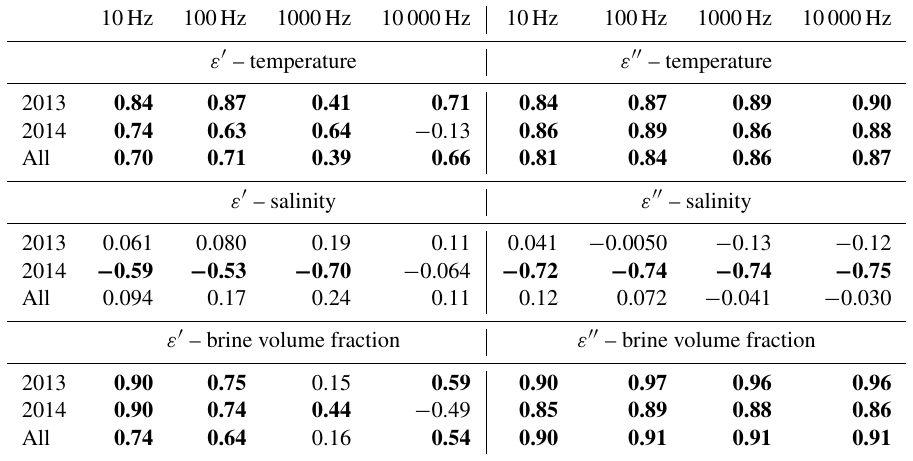
Table 1. Pearson correlation coefficients for the real ( ε (cid:48) ) and imaginary ( ε (cid:48)(cid:48) ) parts of permittivity and ice properties. Coefficients shown in bold are those that are significant at the 5% level.